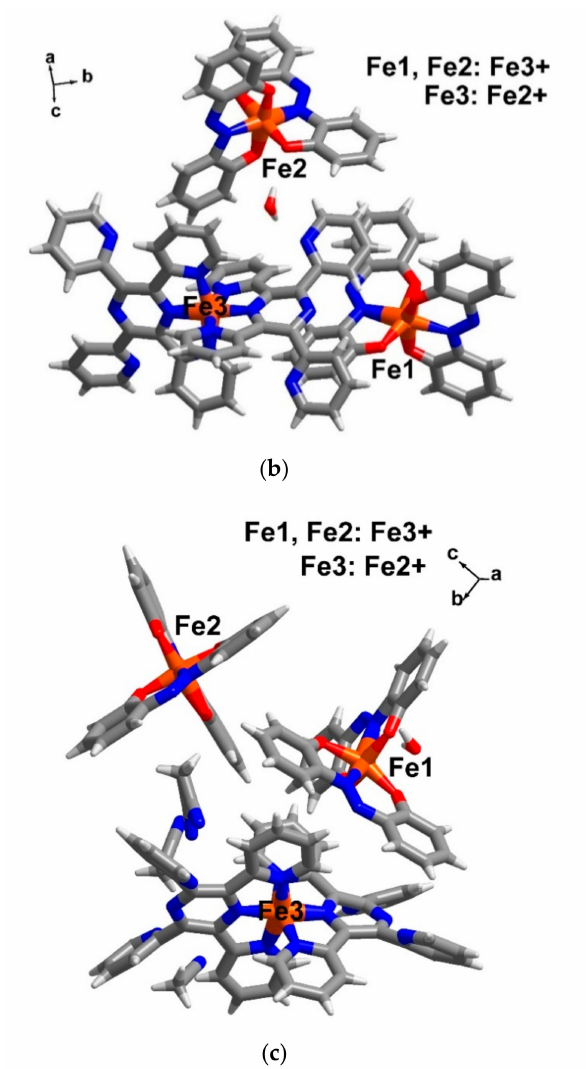
Figure 4. The asymmetric unit of compounds ( a ) 4 , ( b ) 5 and ( c ) 6 in ball and stick model at 100 K. Colour code (element): brown (iron), red (oxygen), blue (nitrogen), grey (carbon) and white